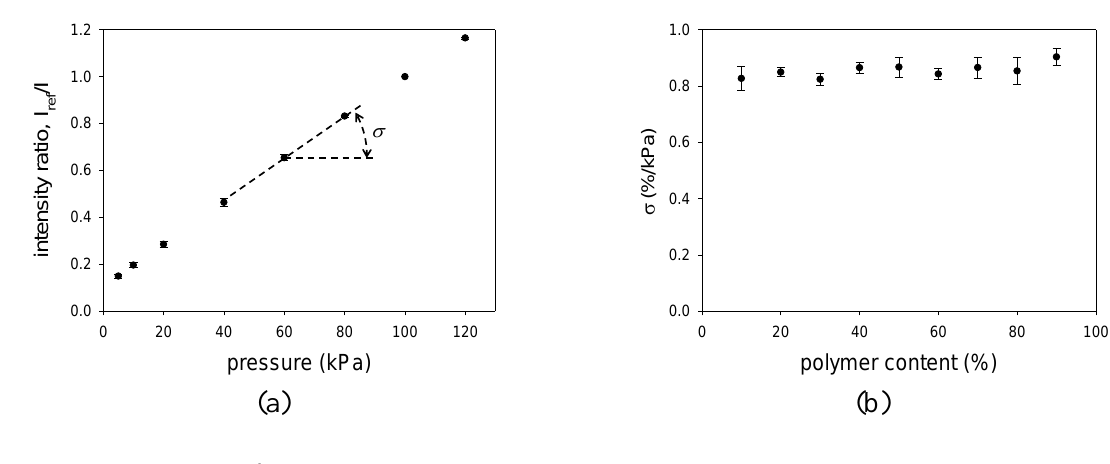
Figure 6. ( a ) The pressure calibration of PCPSP*. ( b ) Relationship between the pressure sensitivity,  (%/kPa), and the polymer content